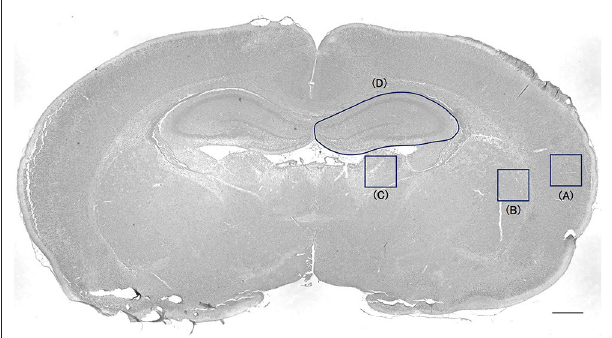
FIGURE 1 | Cell-counting area in the cortex, striatum-pallidum, thalamus, and hippocampus. A square (500 × 500 µ m) was placed on the cortex (A) , the striatum-pallidum (B) , and the thalamus (C) . The hippocampus was outlined (D) . Bar = 500 µ